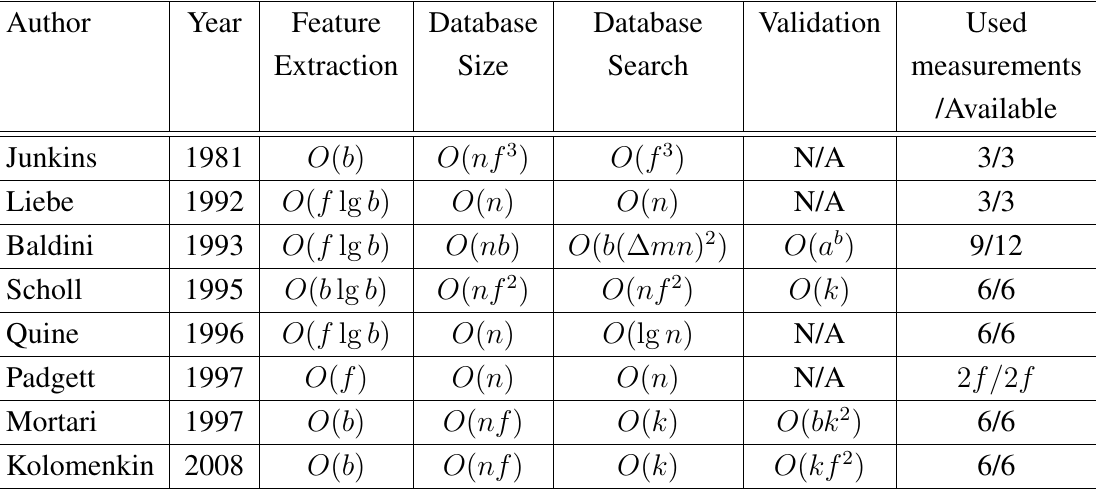
Table 1. Summary of Advances in Asymptotic